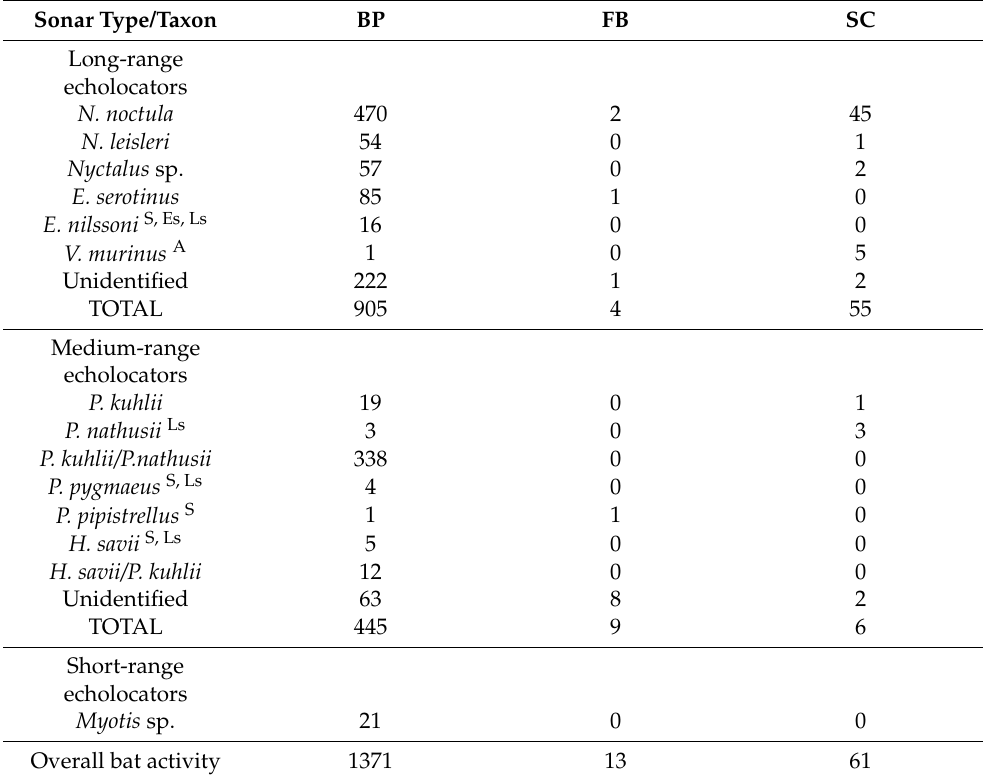
Table 1. List of recorded species and groups of species within ecological guilds, with total numbers of bat passes (BP), feeding buzzes (FB) and social calls